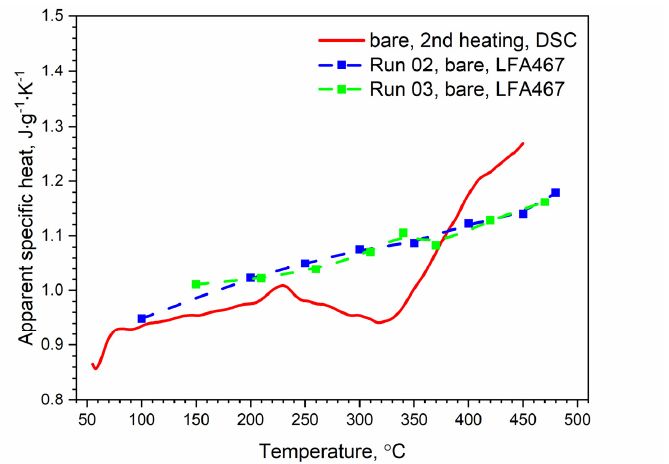
Figure 13. Comparison of the specific heat of the bare AW-2024-T3 alloy obtained from DSC (second heating run) and LFA measurements. Materials 2020 , 13 , 3345